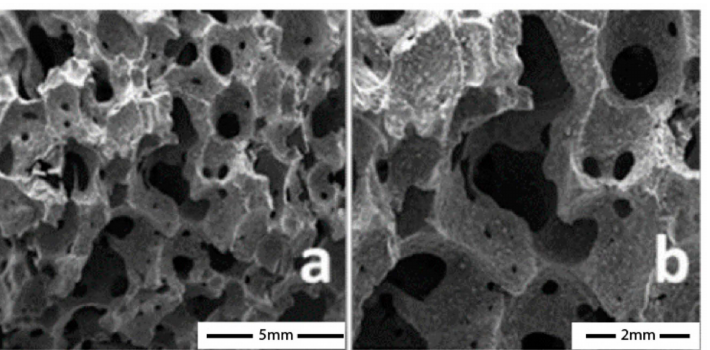
Figure 18. SEM micrographs report the microstructural characterisation of the porous geopolymer samples at 20 × ( a ) and 40 × magnification ( b )